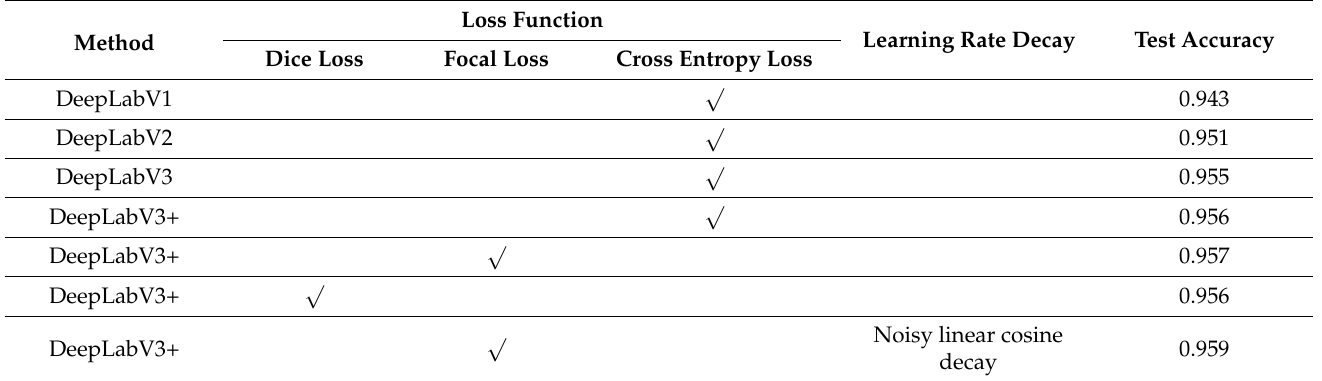
Table 2. Comparison of training skills of DeepLab series models.